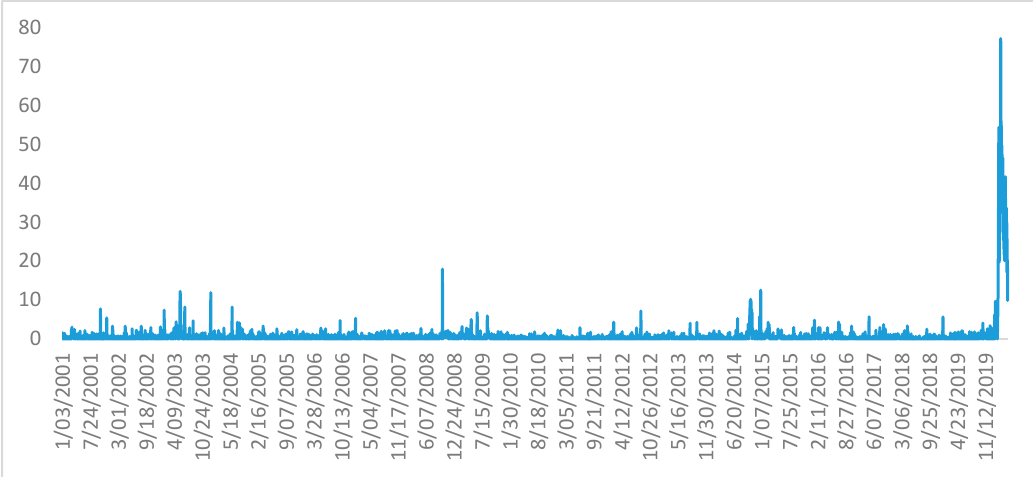
Panel C: Infectious disease equity market volatility (EMV) tracker (EMVID)